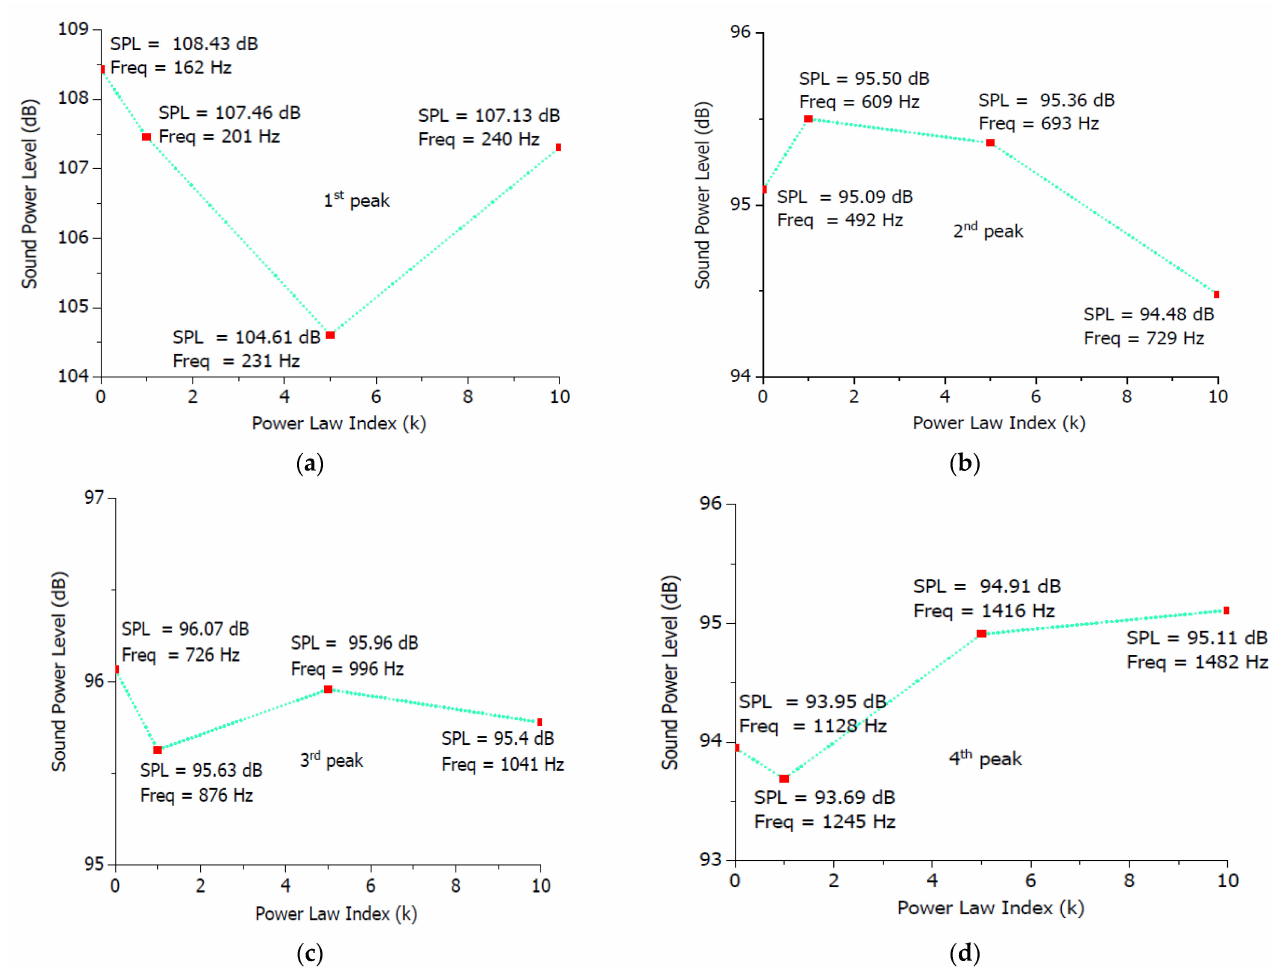
Figure 9. Behavior of variation in k with SPL peaks ( a ) first peak, ( b ) second peak, ( c ) third peak, and ( d ) fourth peak.